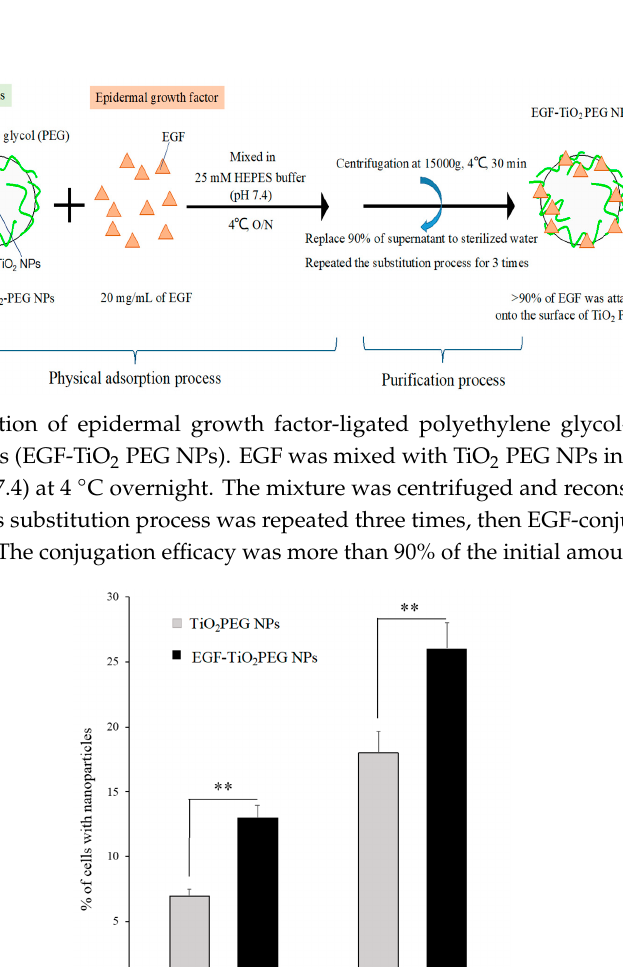
Figure 2. The effect of EGF conjugation on TiO 2 PEG NPs uptake by A431 cells. The percentage of A431 cells incorporated with NPs was assessed by flow cytometry after exposure to TiO 2 PEG NPs (gray bars) and EGF-TiO 2 PEG NPs (black bars) at a concentration of 10 µg/mL (left bars) and 100 µg/mL (right bars) for 24 h. All values are presented as means ± SD ( n ≥ 3). Data were analyzed using the Student’s t -test; ** p ≤ 0.01.